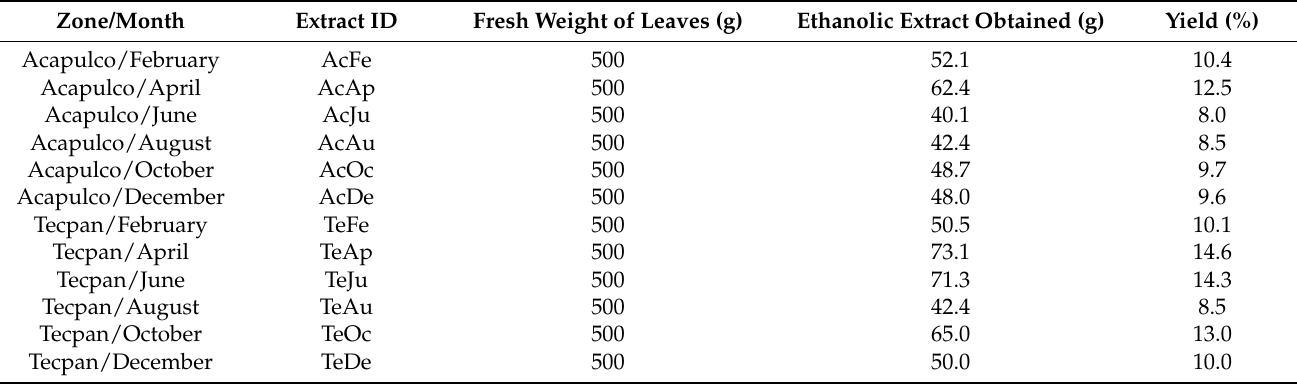
Table 1. Yield of extracts obtained of leaves from Annona muricata collected in Acapulco and Tecpan de Galeana in Guerrero, Mexico for one year